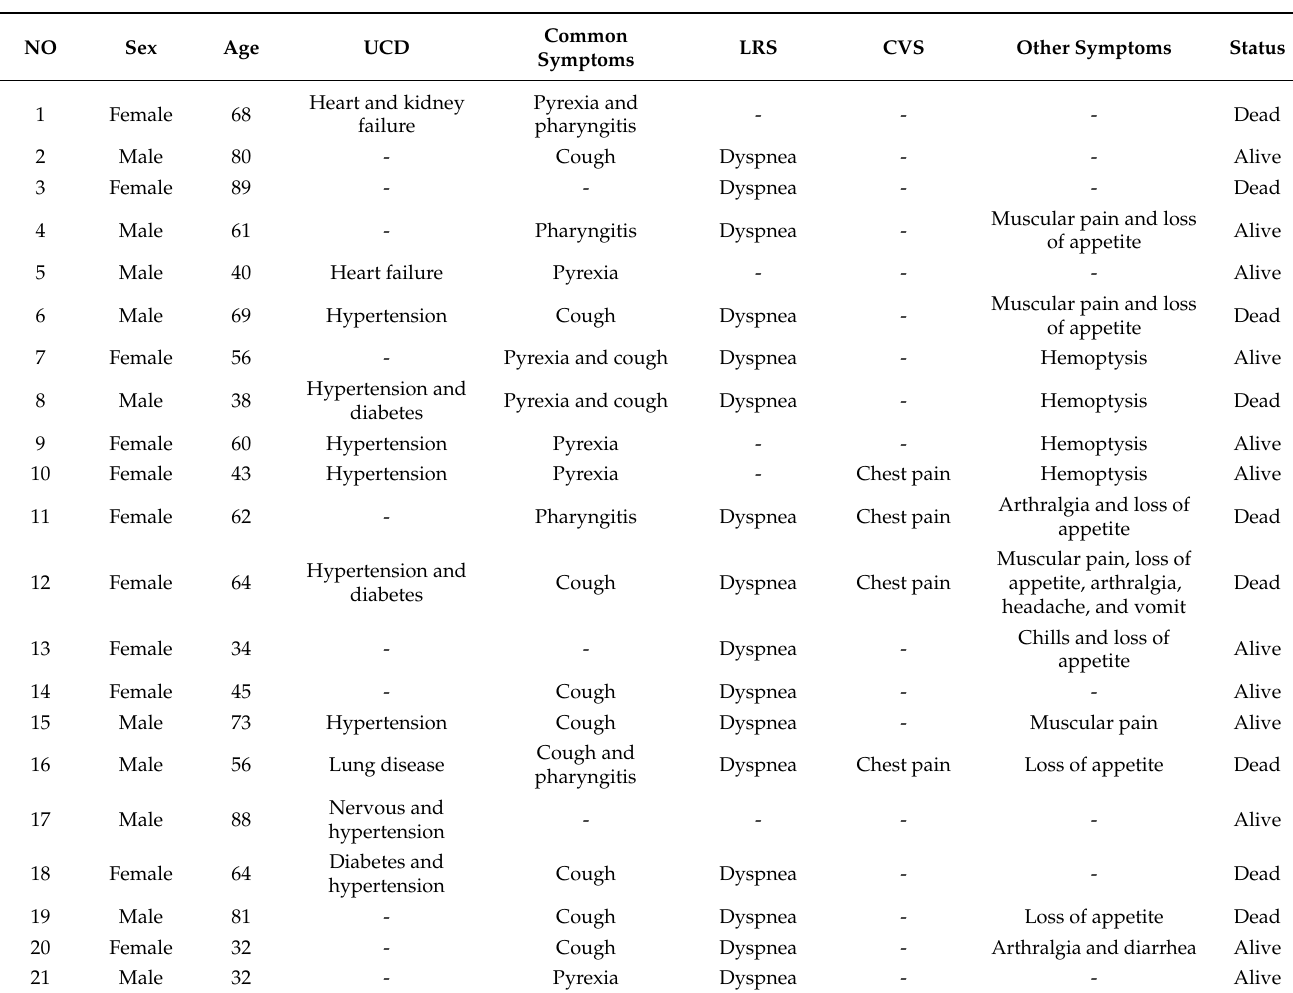
Table 1. The clinical characteristics of